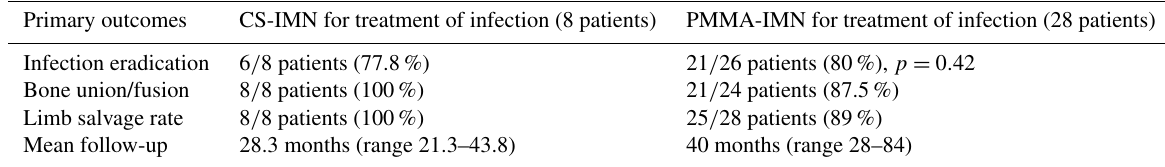
Table 4. Primary outcomes for active infection CS-IMN versus PMMA-IMN. Primary outcomes